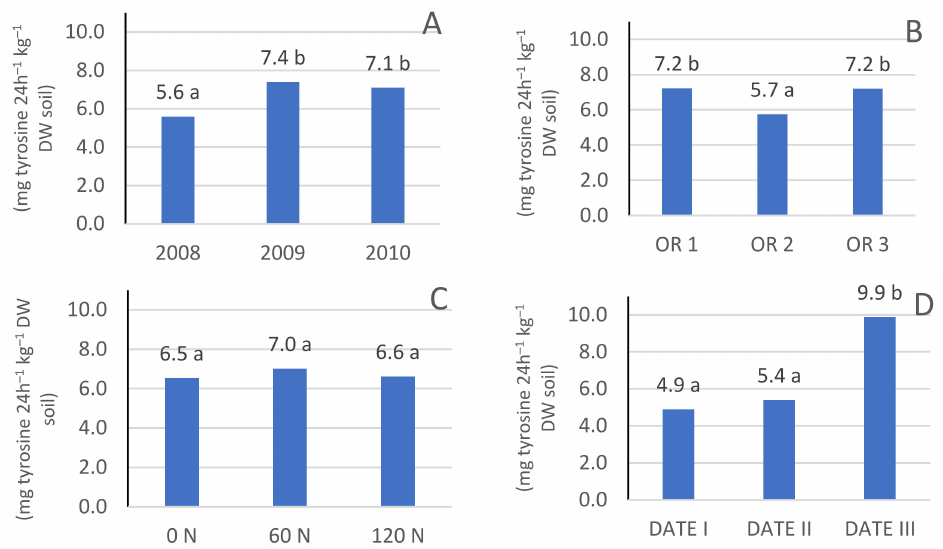
Figure 3. Protease activity in 2008–2010. ( A )—depending on the year; ( B )—depending on the orchard; ( C )—depending on the level of fertilization; ( D )—depending on the timing of sampling.